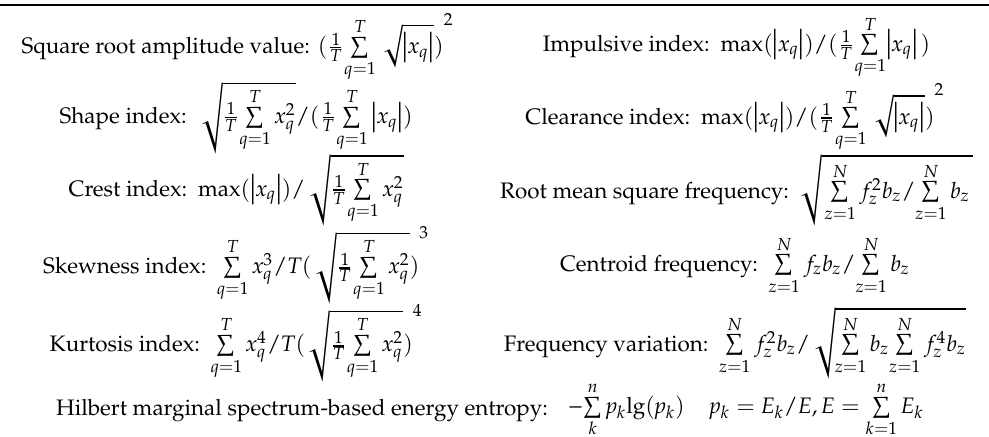
Table 1. Multi-domain features extracted from EEMD